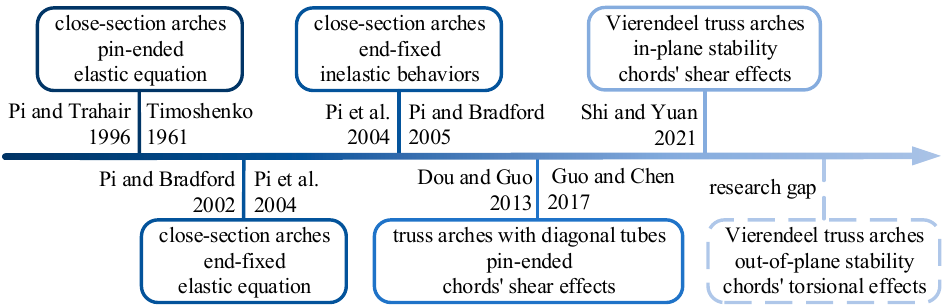
Figure 1. Timeline for researches on the out-of-plane stability of circular steel arches [4,6,7,10,14,19,23–26,29]. To date, the torsional effects of the chords on the out-of-plane inelastic failure mech- anism of the Vierendeel truss arches are still unclear. There are scarce design